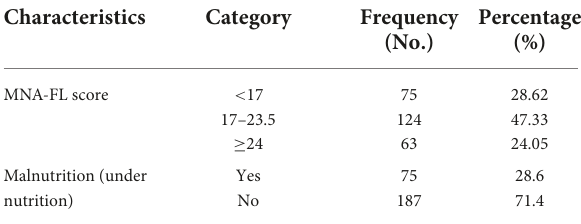
TABLE 8 Mini nutritional assessment (MNA) outcome of older adult patients with heart failure at Cardiac Clinic, University of Gondar hospital, June 01, 2021 to October 31,